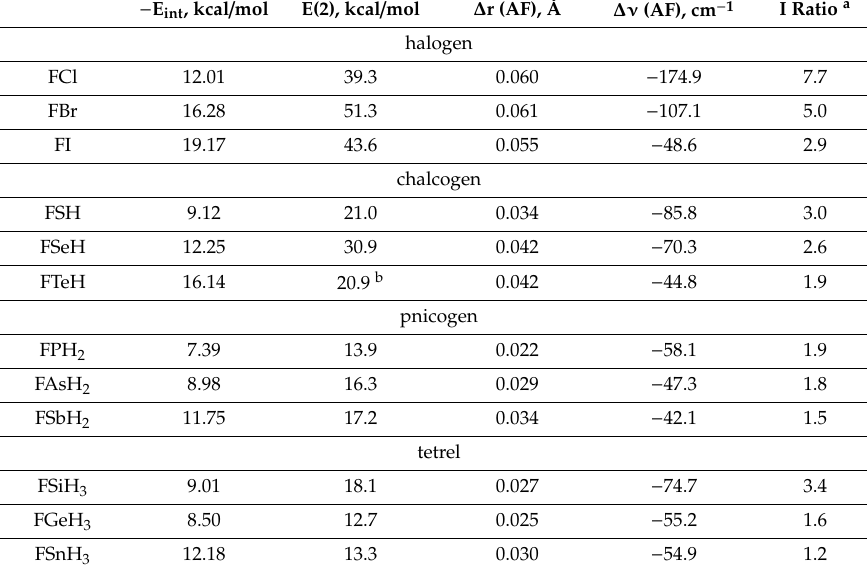
Table 1. Interaction energy, NBO charge transfer energy, bond length change, and bond stretch frequency and intensity change upon forming complex with NH 3 .